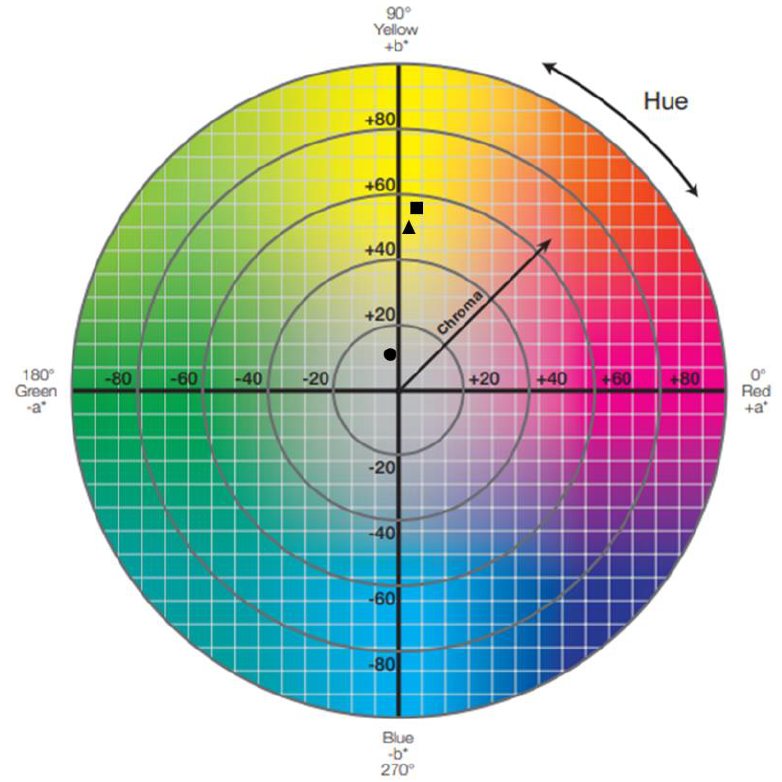
Figure 2. Graphic representation of the color of the three films, (1), (2), and (3), in the CIELAB hue circle (adapted from [40]). Legend: ● — film sample (1): 1.5% chitosan (control); ■ — film sample (2): (2): 1.5% chitosan + 0.5% cutin ddKA + Tween ® 20; (cid:78) —film sample (3): 1.5% chitosan + 0.5% cutin 1.5% chitosan + 0.5% cutin ddKA + Tween ® 20; ▲ — film sample (3): 1.5% chitosan + 0.5% cutin dNaA + Tween ® 20. dNaA + Tween ®